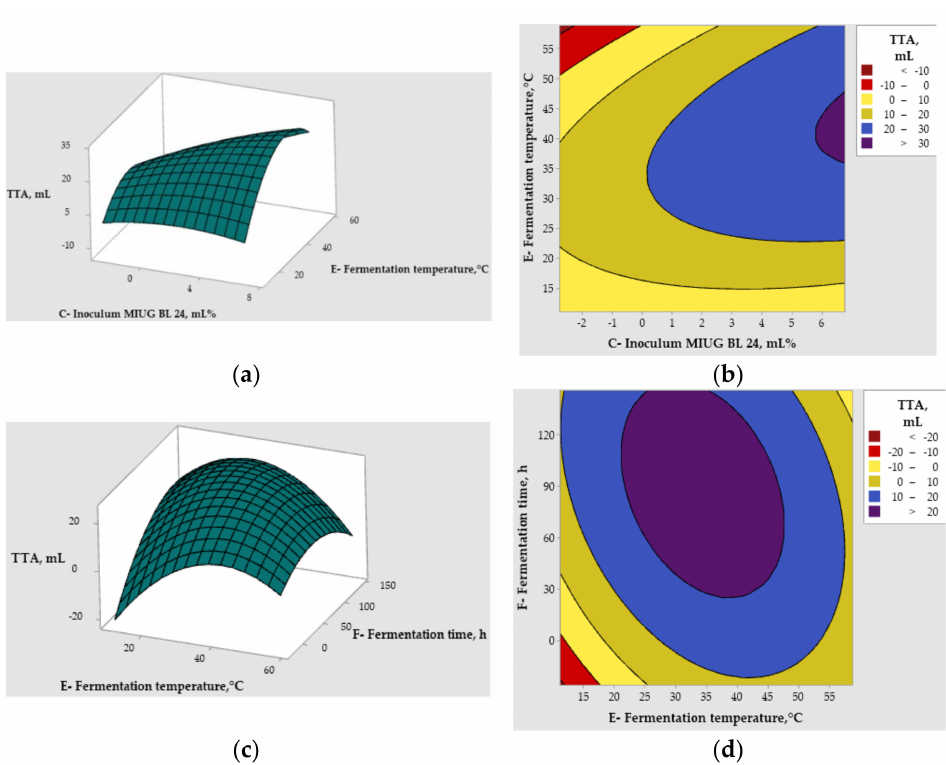
Figure 1. Surface (left) and contour (right) plots for the two-way interactions between the significant fermentation factors on the total titratable acidity (TTA, mL NaOH 0.1N). Surface ( a ) and contour ( b ) plots for the interaction between the factors C and E , and ( c ) surface and ( d ) contour plots for the interaction between the factors E and F . The mean of the factors A to F is given in Table